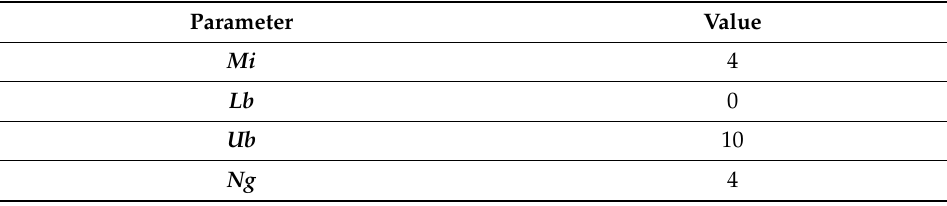
Table A1. The Optimal values of